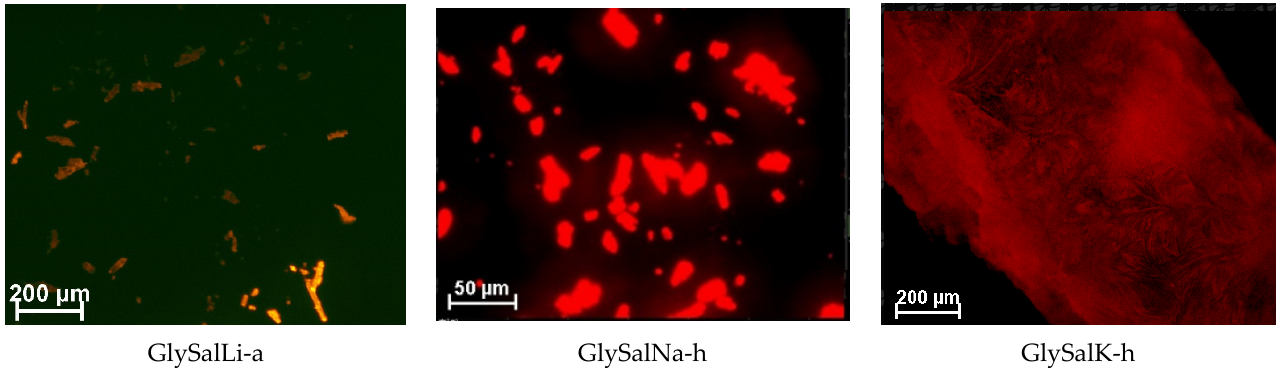
Figure 6. Time domain intensity decay of GlySalLi. The instrument response function ( black squares ) and exponential decay fit ( red line ).